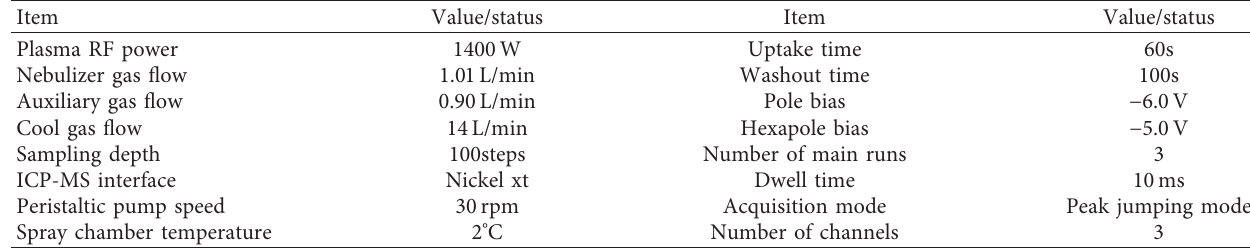
Table 2: ICP-MS working conditions.